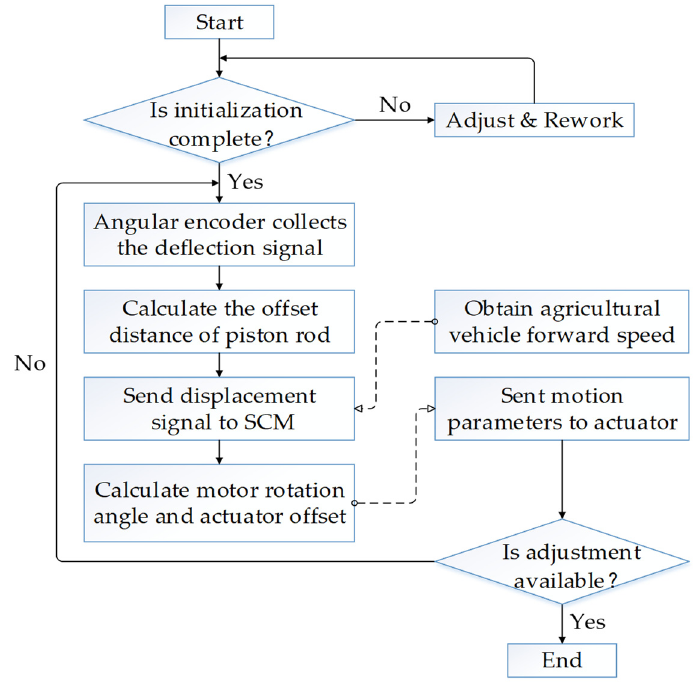
Figure 5. Algorithm flow chart of deflection control system.